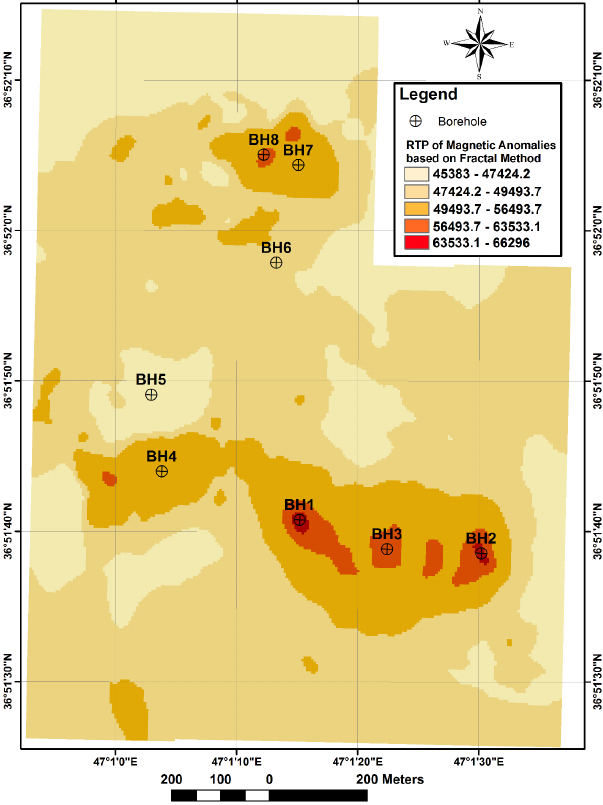
Figure 8. RTP map of Qoja-Kandi based on the C – A method with drilled